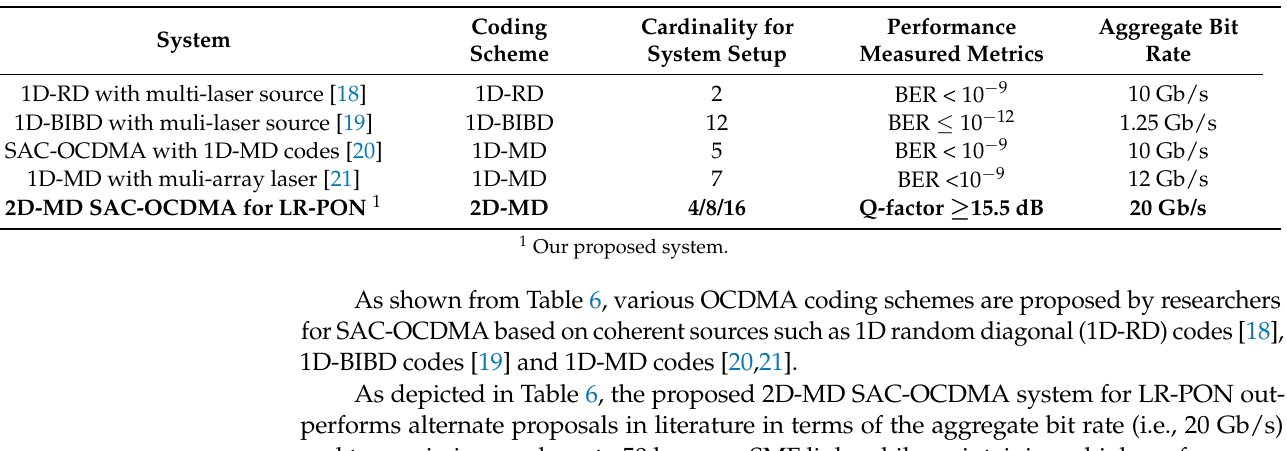
Table 6. Comparison of SAC-OCDMA systems based on coherent